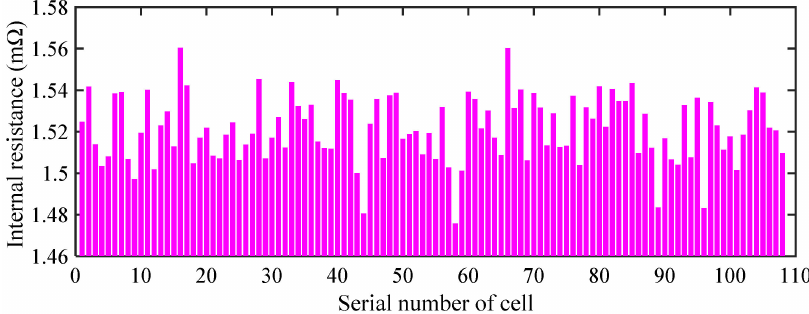
Figure 7. Calculation results of discharge internal